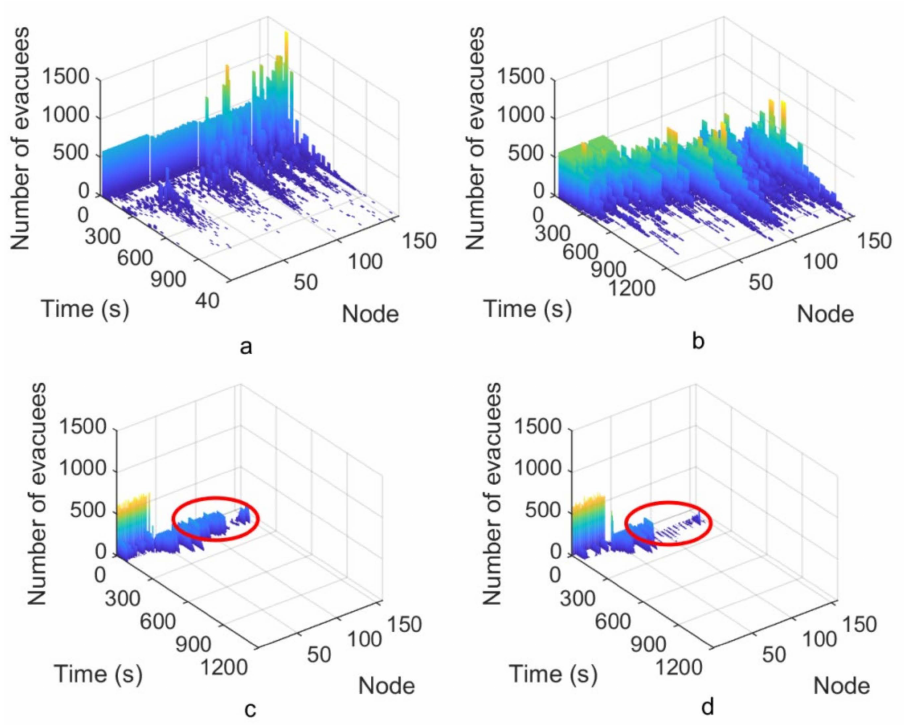
Figure 8. Temporal-spatial congestion of four approaches. ( a ) ACO. ( b ) HMERP. ( c ) HDAFSA. ( d )